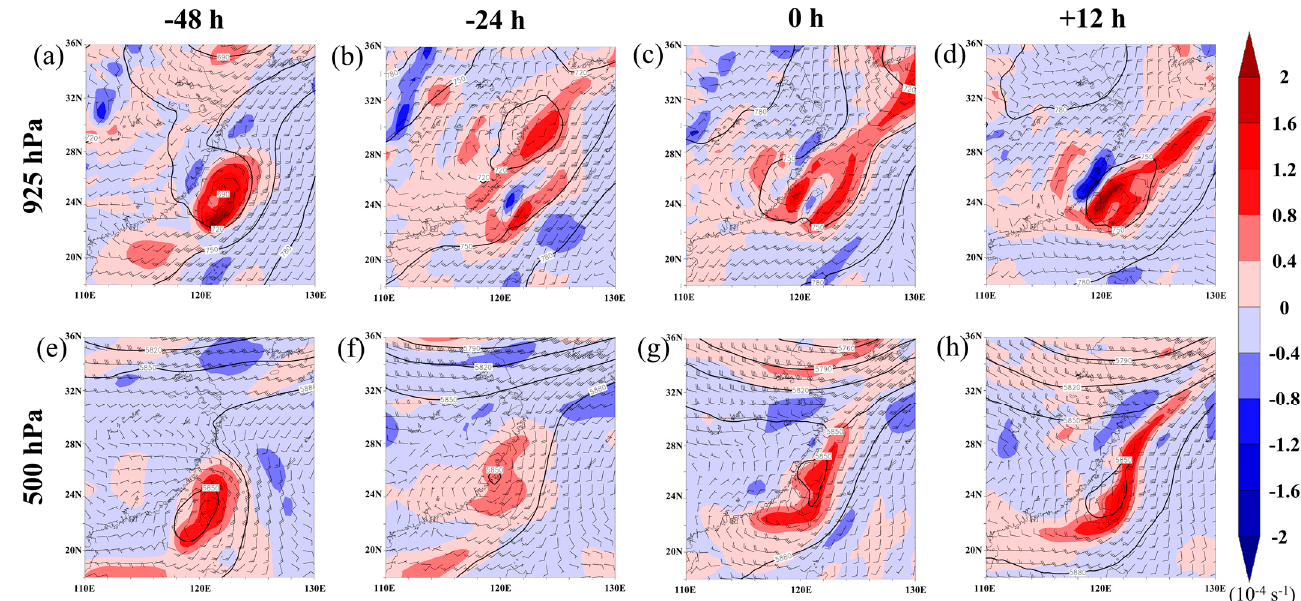
Figure 3. ( a – d ) 925-hPa and ( e – h ) 500-hPa relative vorticity (shading; 10 − 4 s − 1 ), wind fi elds, and geopotential height (contours; gpm) in ERA-Interim reanalysis data at ( a , e ) 0000 UTC 29, ( b , f ) 0000 UTC 30, ( c , g ) 0000 UTC 31 and ( d , h ) 1200 UTC 31 August 2013.